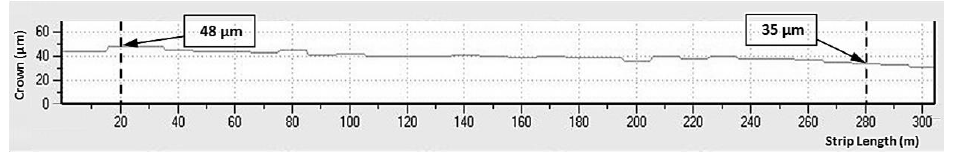
Figure 3. Original record of crown from the online thickness measuring device.